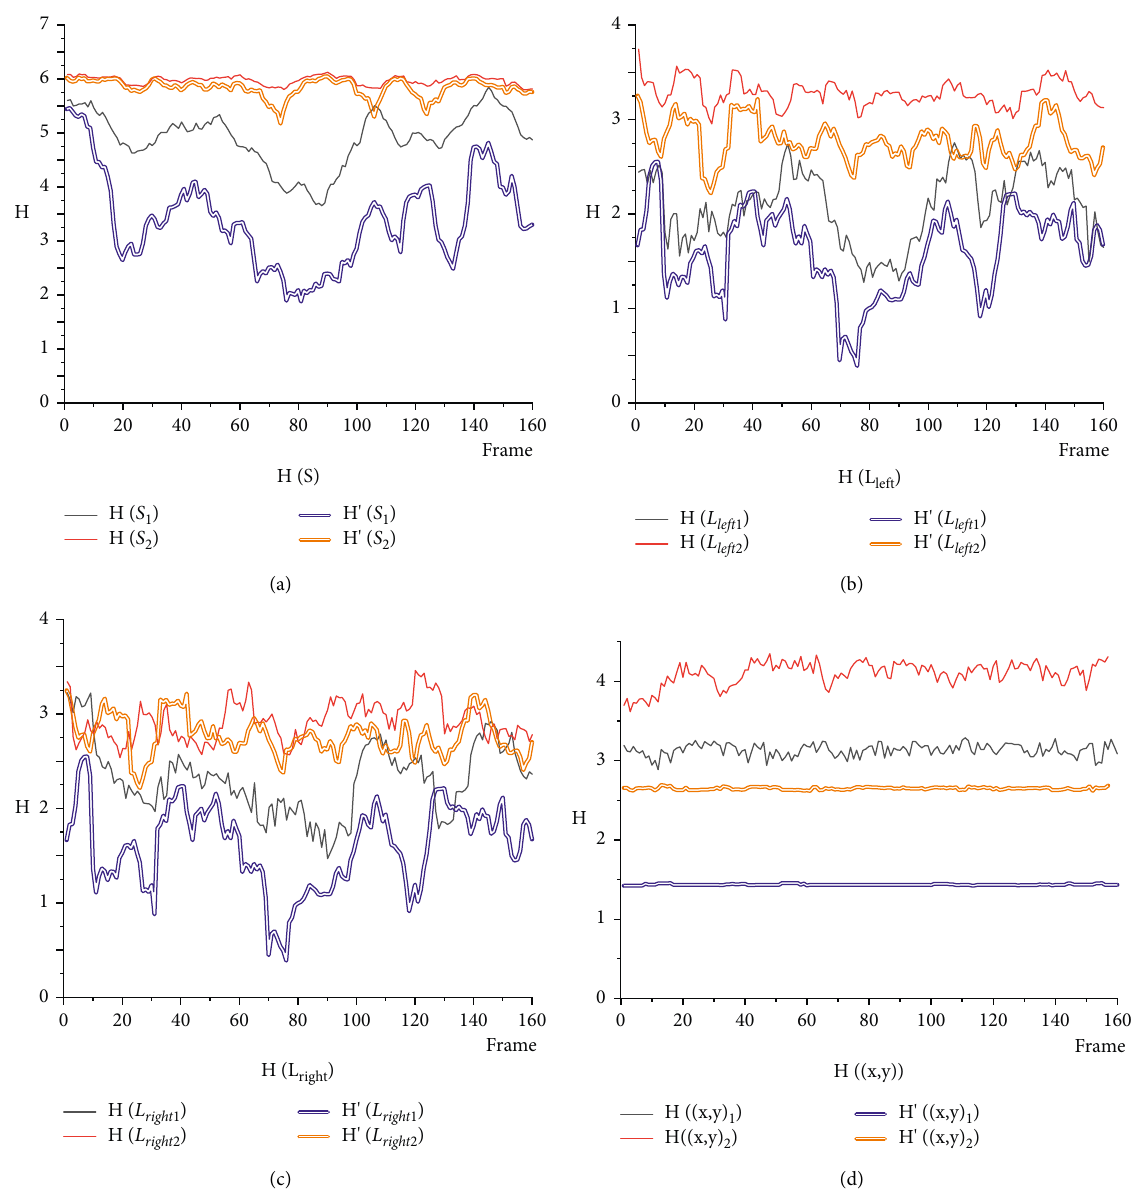
Figure 13: When comparison of information entropy changes before and after adding the correction factor, the information entropy result ( H ) represents the result before adding the correction factor (red and black broken lines in the figure), while the information entropy result ( H ′ ) represents the result after adding the correction factor (yellow and blue broken lines in the figure). Among them, (a), (b), (c), and (d) represent the information entropy changes of L left , L right , ( S ), and ( x , y ), respectively. S 1 , L left1 , L right1 , and ( x , y ) 1 represent the information entropy in the fatigue state, and S 2 , L left2 , L right2 , and ( x , y ) 2 represent the information entropy in the normal